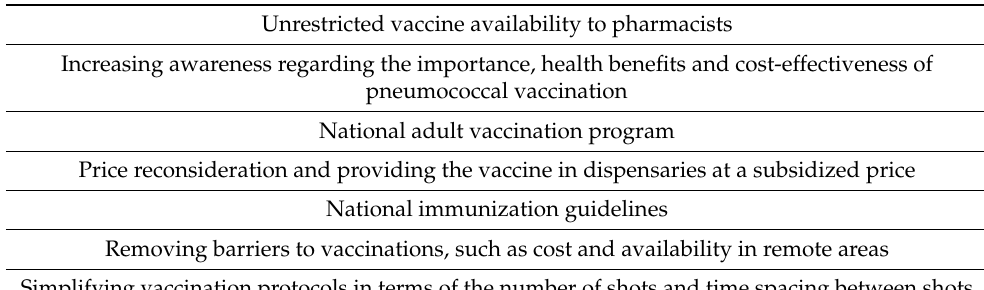
Table 4. Ways to enhance adult vaccination in